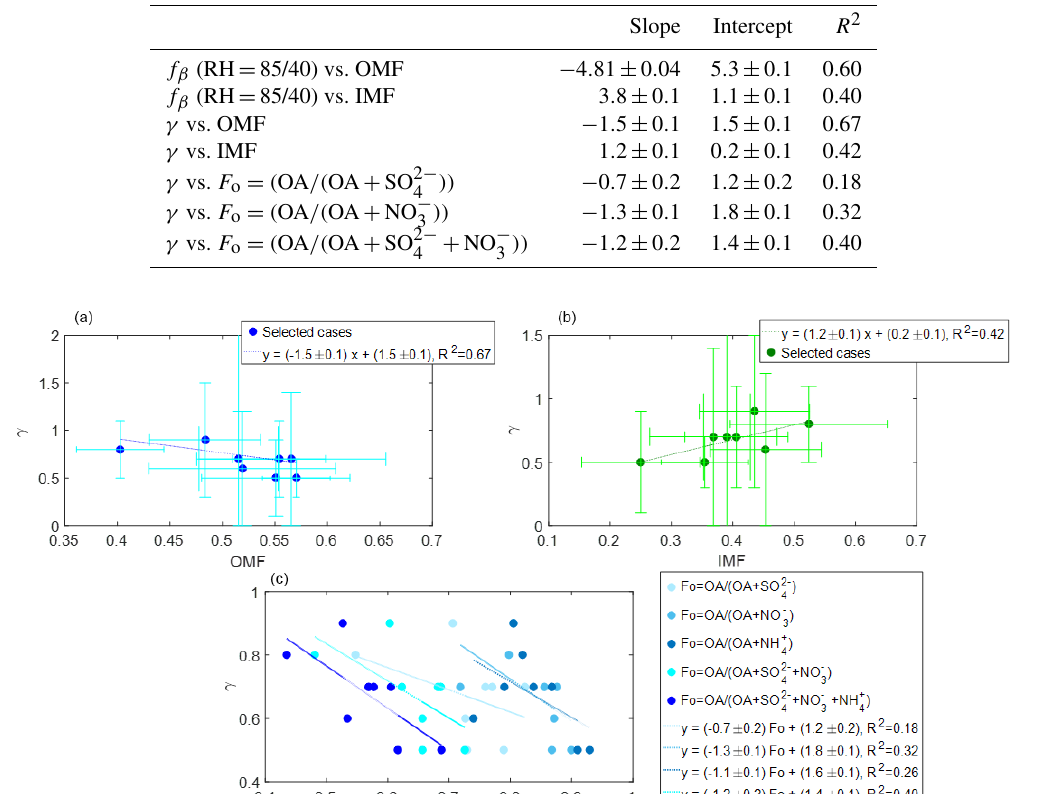
Figure 4. Mass fraction and γ parameter correlation for the eight hygroscopic growth cases. (a) The OMF against γ is noted in blue dots with error bars, and the dashed line is the linear fit; (b) the IMF and γ correlation is noted in green dots with the respective error bars of the gamma and the OMF/IMF uncertainties, and the dashed line represents the linear fit; and (c) the correlations of the relative amount of OA and IA ( F o ) versus γ . F o is defined according to the